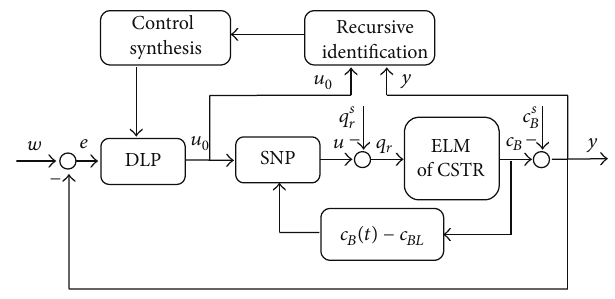
Figure 6: Control scheme of the nonlinear adaptive